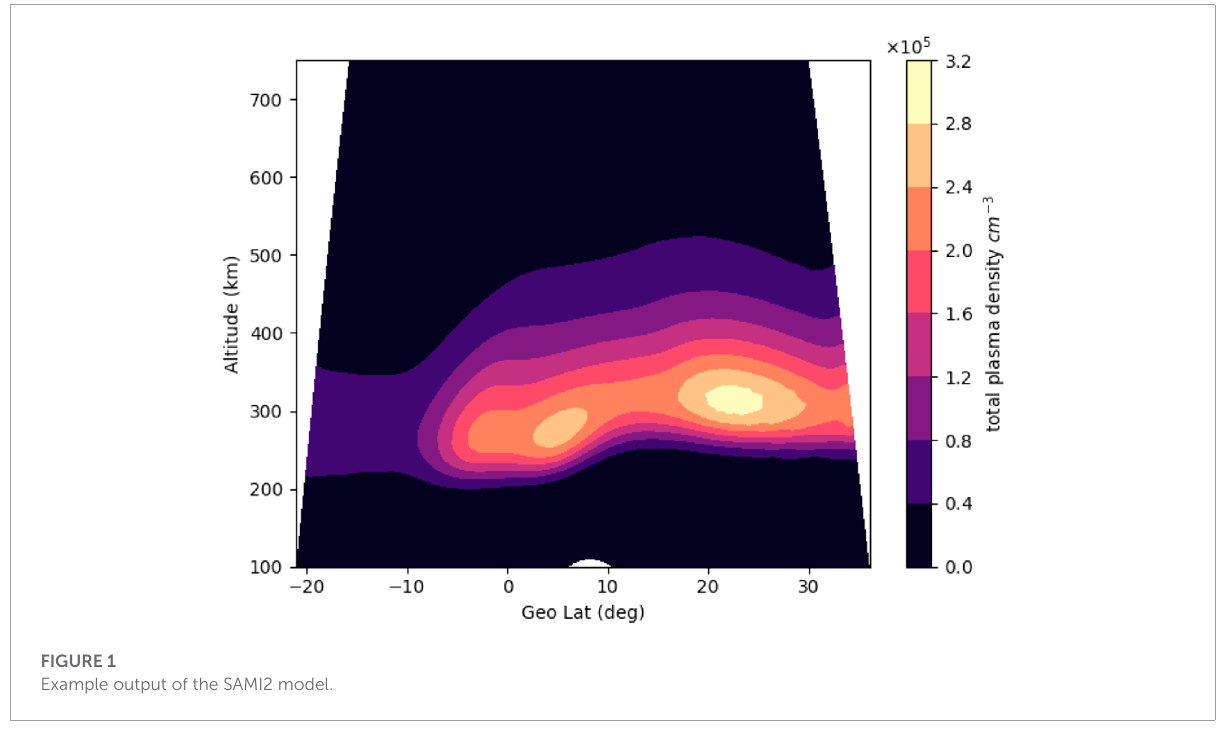
FIGURE 1 Example output of the SAMI2 model.